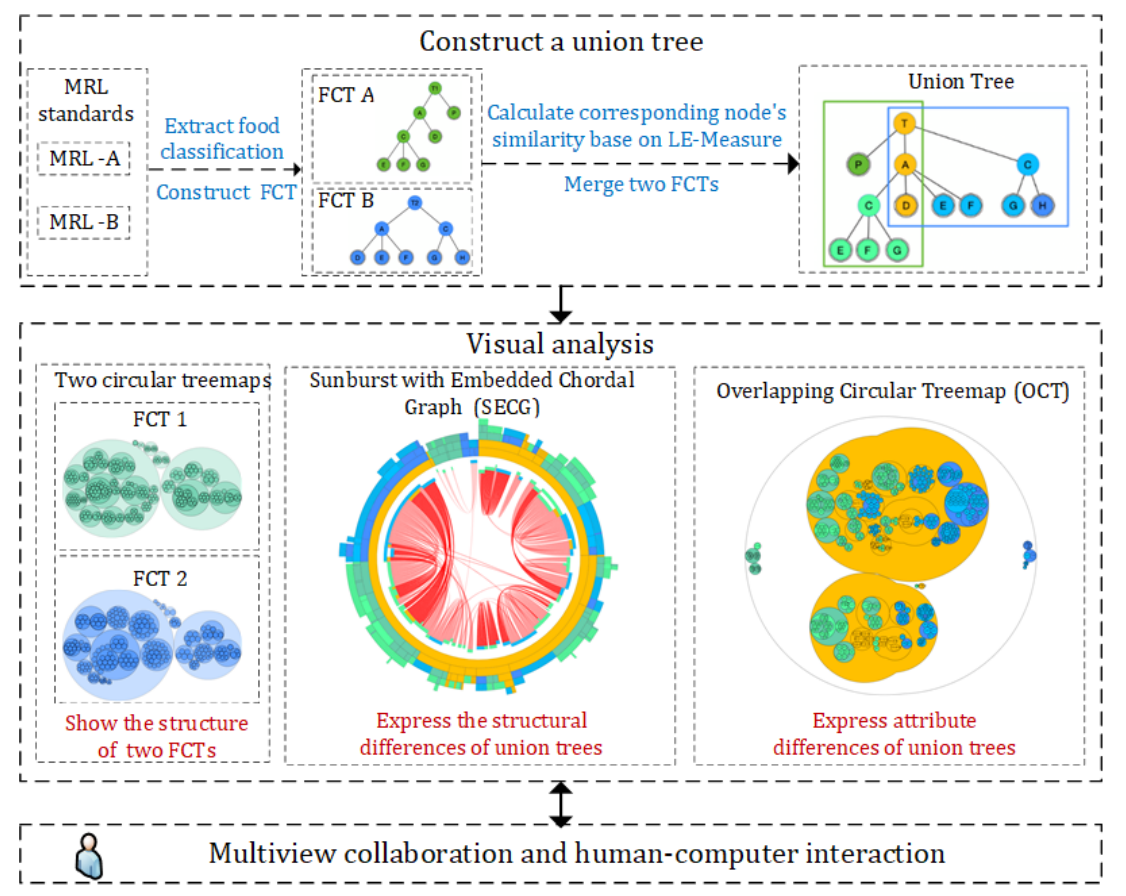
Figure 3. The pipeline of TreeMerge.